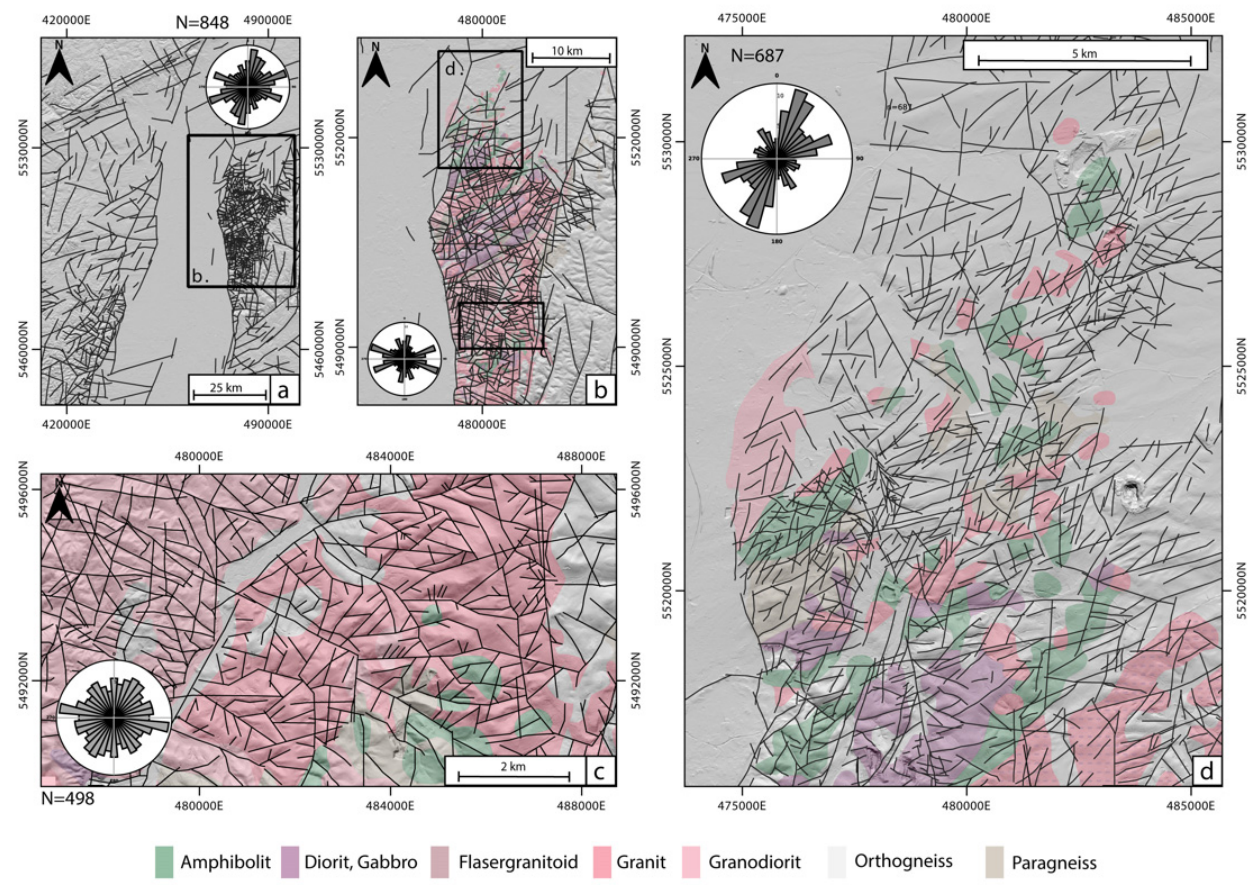
Figure 3. Lineament maps from the Northern URG, ( a ) 25 m resolution regional map, ( b ) close-up on the Odenwald, ( c ) 5 m resolution close-up of the southern Odenwald and ( d ) 5 m resolution close-up on the northern Odenwald [15]. For b, c and d; the colour code corresponds to the geological background and is adapted from [79] (see Figure 1 for the legend).